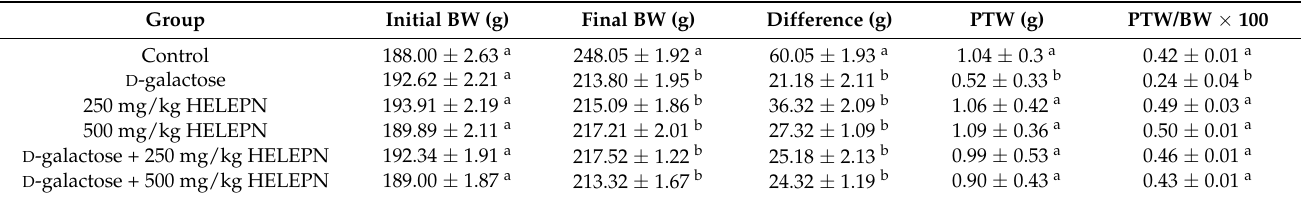
BW, bodyweight of rats; PTW, paired testicular weight . Values are means of five replicates ± SEM. Values carrying different superscripts (a, b) are significantly different at p < 0.05.